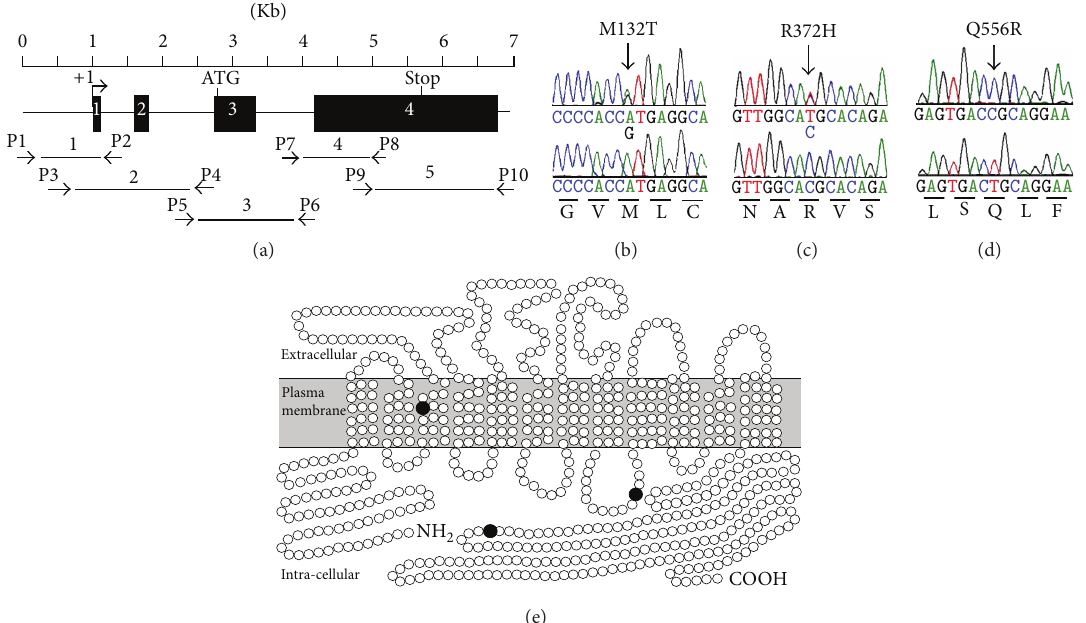
Figure 1: Identification of variants in the human SLC26A1 gene and predicted amino acid substitutions. (a) Schematic of SLC26A1 showing 4 exons (boxes), transcription initiation site (+1, arrow), and the relative location of PCR primers (P1–P10) and PCR amplicon fragments (1–5) used for DNA sequence analysis. ((b)–(d)) Representative DNA sequence chromatographs showing variant ( top panels ) and control ( bottom panels )sequencesthatpredict(b)heterozygousM132T,(c)heterozygousR372H,and(d)homozygousQ556R.Reversecomplementnucleotide sequences are shown. (e) Position of amino acid substitutions ( ∙ ) in the predicted secondary structure model of the human SAT1 protein [25]. M132T within the third transmembrane domain; R372H in the fourth intracellular loop; and Q556R in the intracellular carboxy-terminal